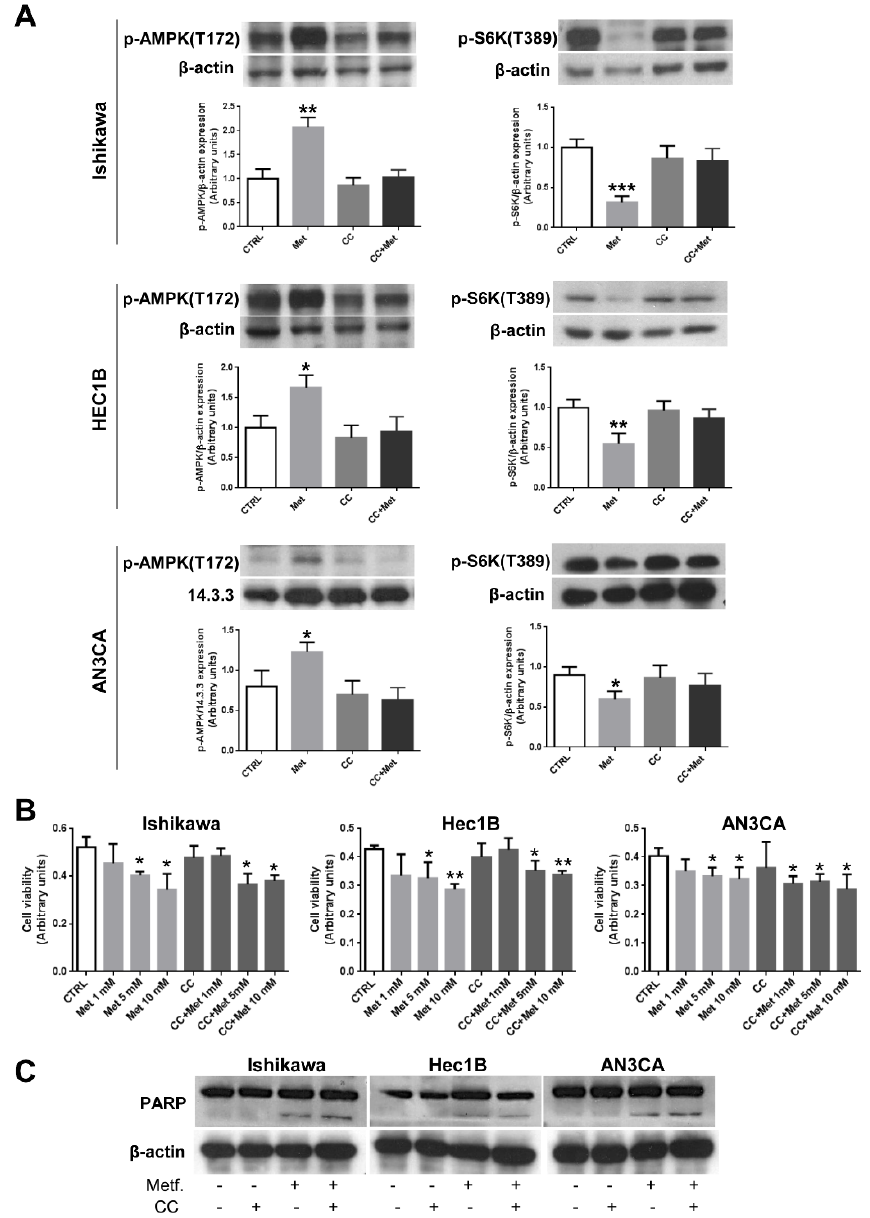
Figure 2. Inhibition of AMPK by CC does not alter metformin effects on endometrial cancer cells. ( A ) Ishikawa, HEC1B, or AN3CA cells were treated or not for 24 h with 5 mM metformin or 10 µ M CC or pretreated for 1 h with 10 µ M CC followed by treatment with 5 mM metformin. Total cellular proteins were extracted and Western blot experiments were performed, as described in the Section 2.3, using antibodies against p-AMPK (left panels) or p-S6 kinase (right panels). Data represent the mean ± SD of three independent experiments. * p < 0.1; ** p < 0.05; *** p < 0.01. ( B ) Ishikawa, HEC1B, or AN3CA cells were seeded at a density of 5 × 10 3 cells in a 96-well plate. After 16 h, cells were treated or not with increasing concentration of metformin in the presence or absence of 1 h pretreatment with 10 µ M CC. Cell viability was measured after 48 h using the MTT assay. Values represent the mean absorbance at 570 nm ± SD of triplicates of three independent experiments. * indicates a p -value < 0.05; ** indicates a p -value < 0.01. ( C ) Ishikawa, HEC1B, or AN3CA cells were treated or not for 48 h with 5 mM metformin or 10 µ M CC or pretreated for 1 h with 10 µ M CC followed by treatment with 5 mM metformin. Total cellular proteins were extracted and Western blot experiments were performed, as described in the Section 2.3, with antibodies against PARP or β -actin (loading control).